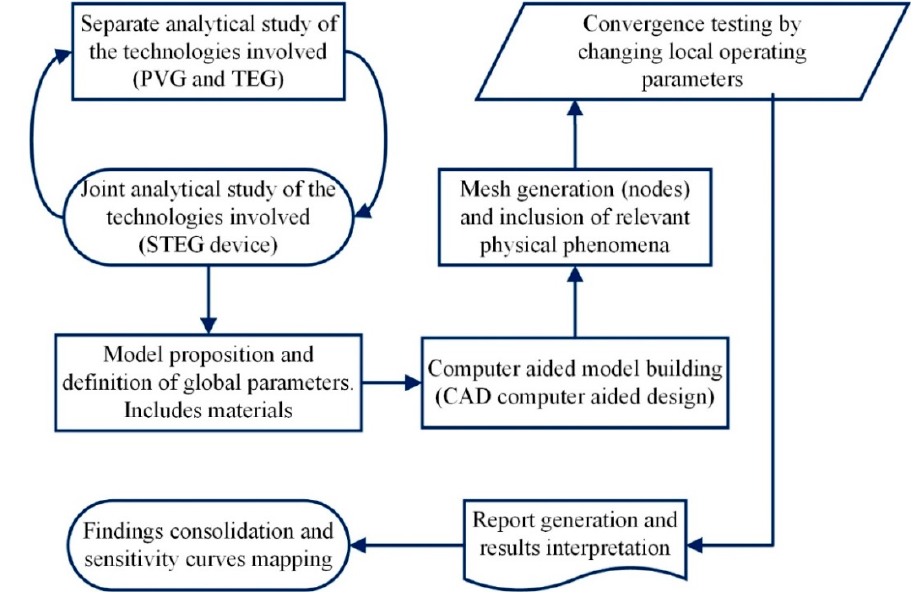
Figure 13. Research modeling strategy.